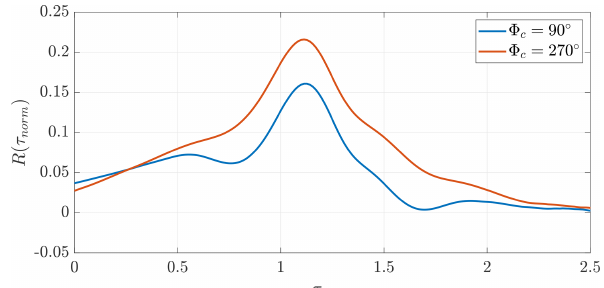
Figure 5. Average power output fluctuation correlation for wind di- rection intervals around 90 and 270 ◦ considering the wind turbines 9 to 57 in the symmetric square (see Fig. 1). (cid:56) c depicts the centre of the wind direction